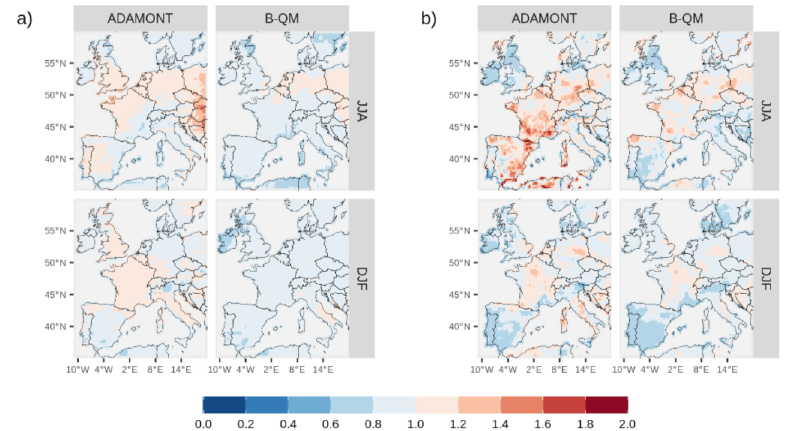
Figure 12. Spatial distribution of SPR for ( a ) 2-m mean air temperature and ( b ) precipitation in JJA and DJF for calibrated seasonal forecasts (one-month lead time) by ADAMONT and B-QM over